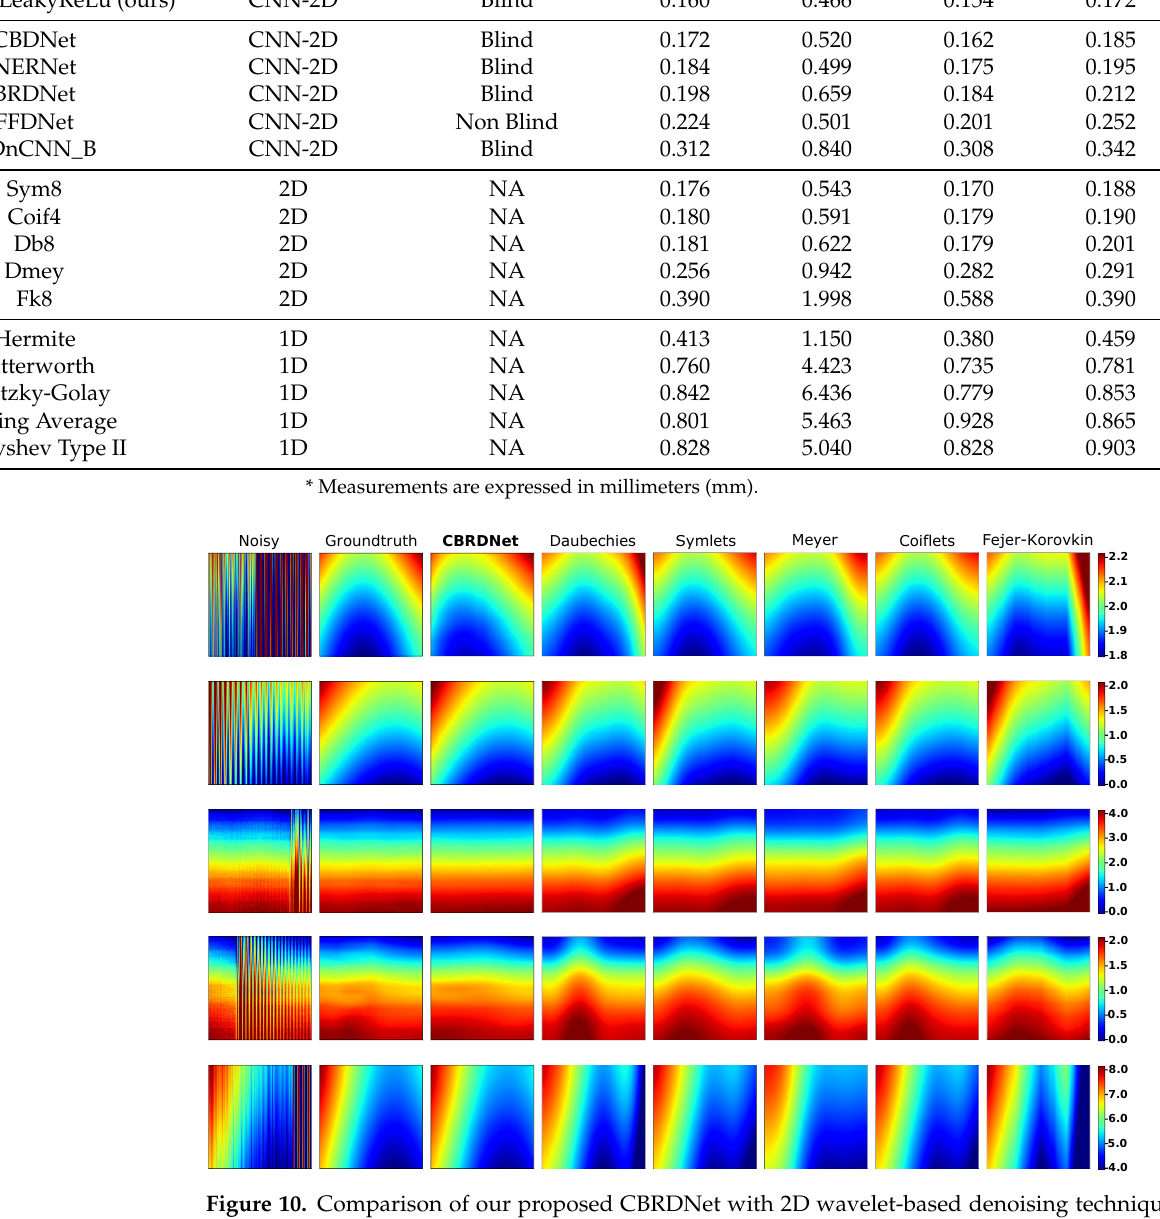
Figure 10. Comparison of our proposed CBRDNet with 2D wavelet-based denoising techniques. Noisy synthetic samples have very low SNR, hence the the groundtruth surface of the samples is almost lostt in some samples. To facilitate the comparison with the denoised samples, the color scale of the images corresponding to the first column, i.e., noisy sample, is clipped. Color scale values are expressed in millimeters (mm). (Color